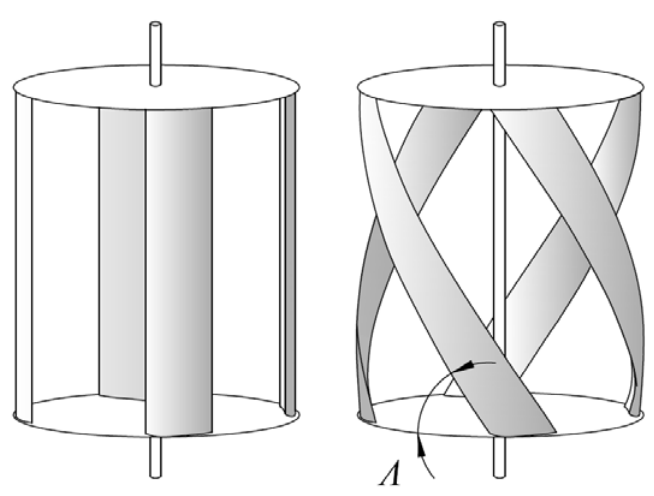
Figure 1. Straight and helically bladed